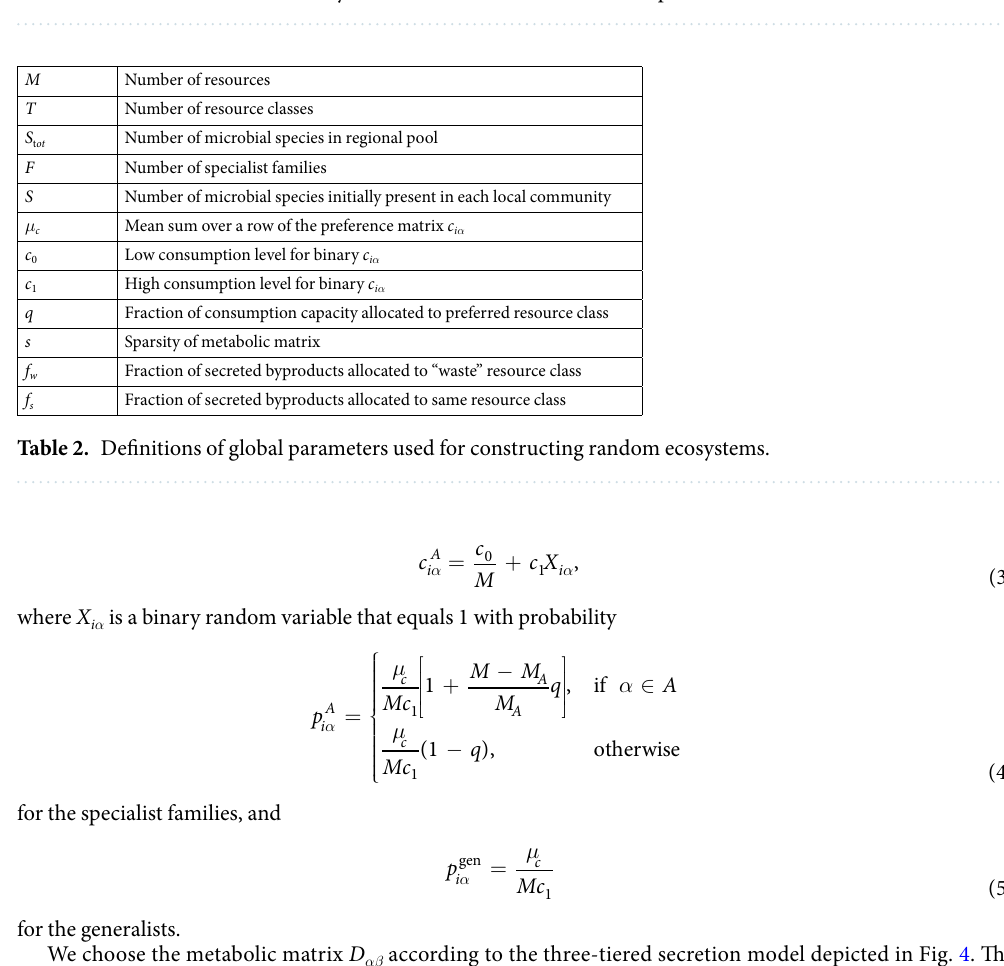
Table 1. Definitions and units for dynamical variables and mechanistic